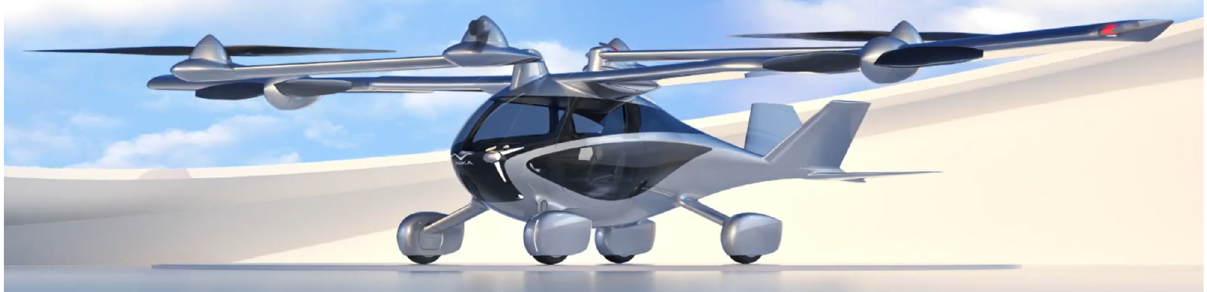
Figure 9: An imagined view of the ASKA fl ying car with the wing and propeller - carrying arms extended ( image credit: NFT Inc., used with permission )